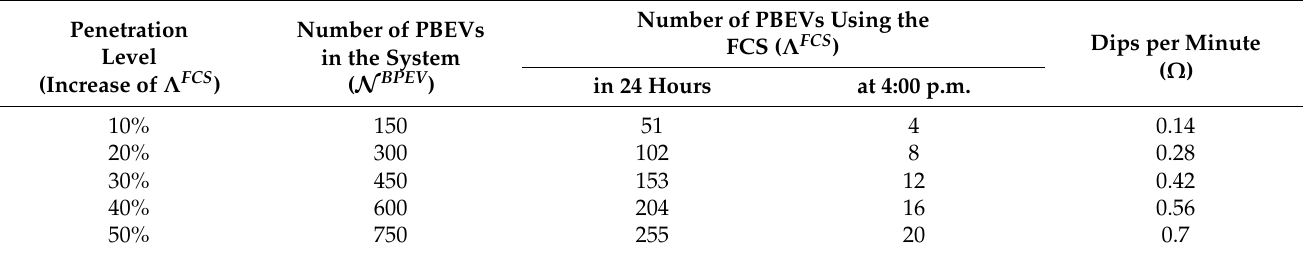
Table 3. Number of PBEVs Charging via Fast Charging